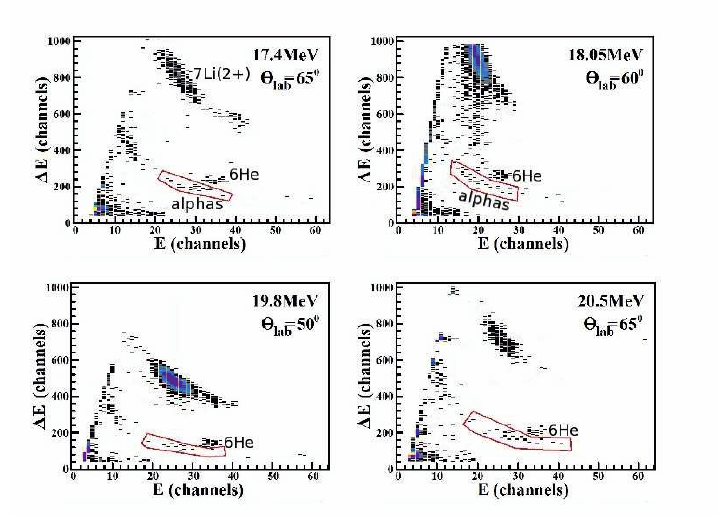
Figure 3. Experimental biparametric spectra for 6 He + 120 Sn from ref. [9]. The contaminant 7 Li peak is shown as well as the alpha particles distribution.